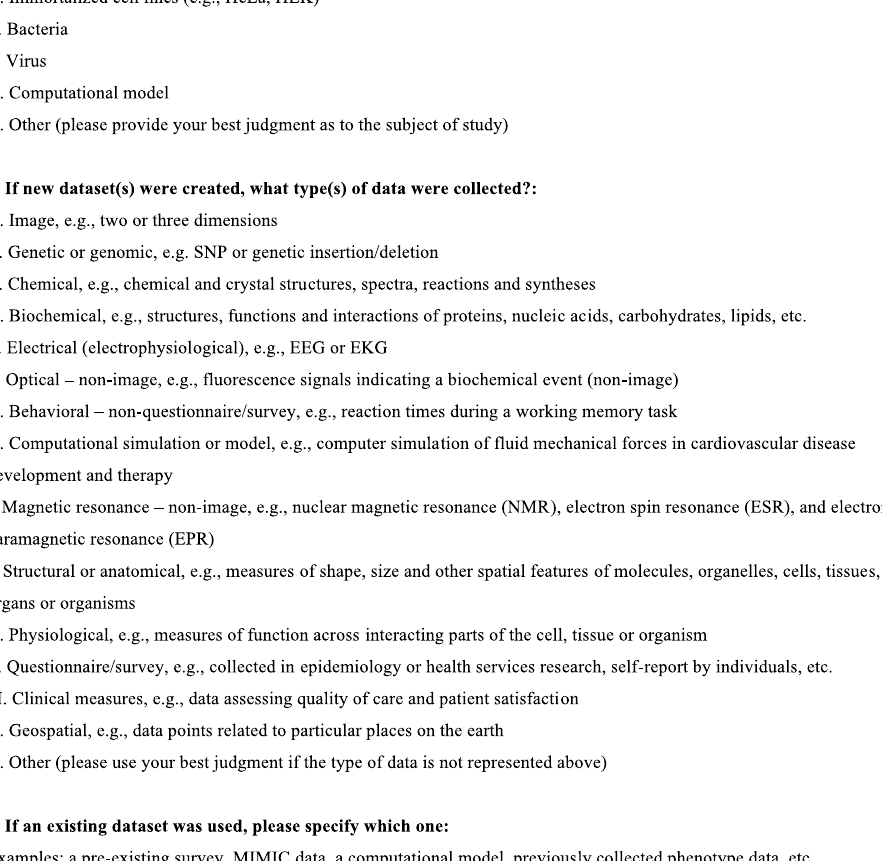
Fig 3. Questions for annotating datasets contained in research articles.